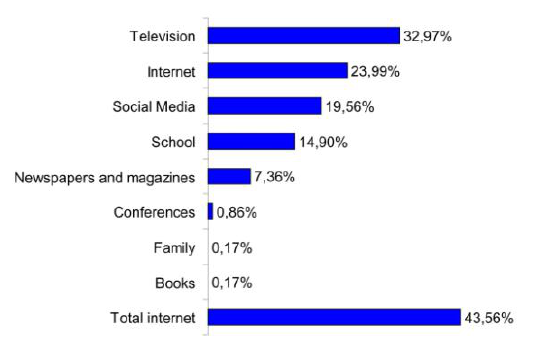
Figure 2. Sources of information. Students could choose up to three